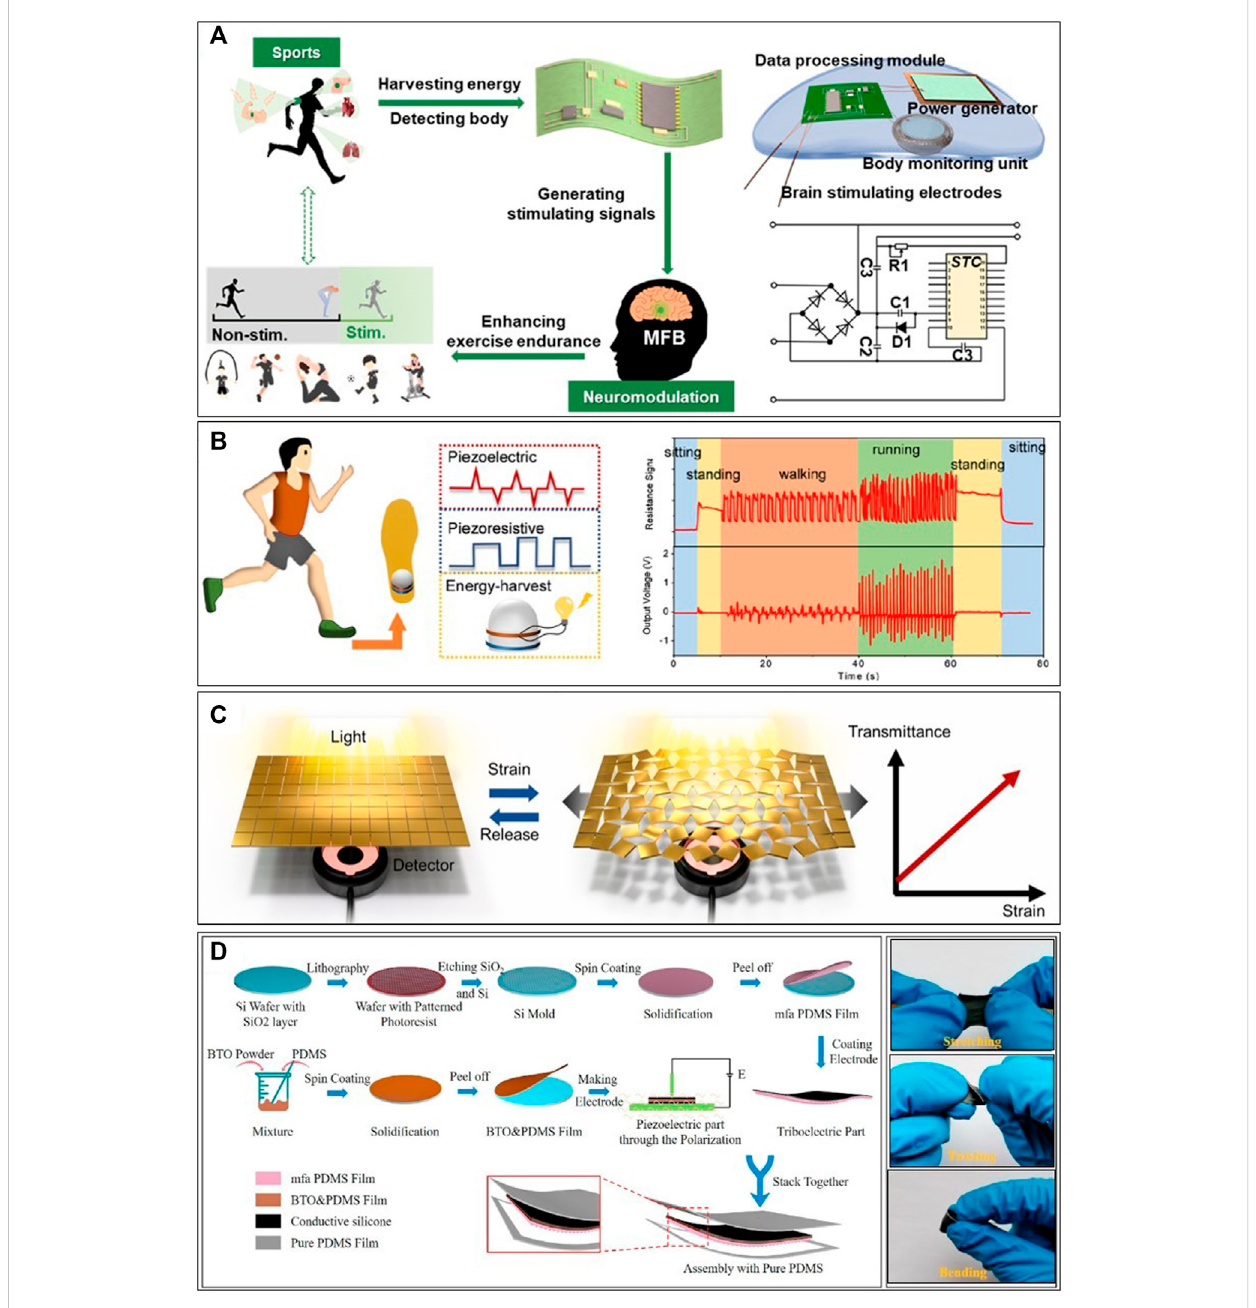
FIGURE 1 (A) Schematic illustration of the wearable and real-time brain-machine-interface system for enhancing exercise endurance showing the four parts of the system and the electronic circuit of the data processing module (Liang et al., 2022). (B) Schematic diagram of the dual-mode device incorporated into the insole to detect human motion via voltage/resistance variation of the dual-mode sensor during a series of body movements (Kong et al., 2022). (C) Schematic illustration of the GDE-R (the rotating square pattern) based piezo-transmittance strain sensor (Gu et al., 2021). (D) The fabrication process of the P-TPS and optical photos of the P-TPS under different deformations (Yu et al.,